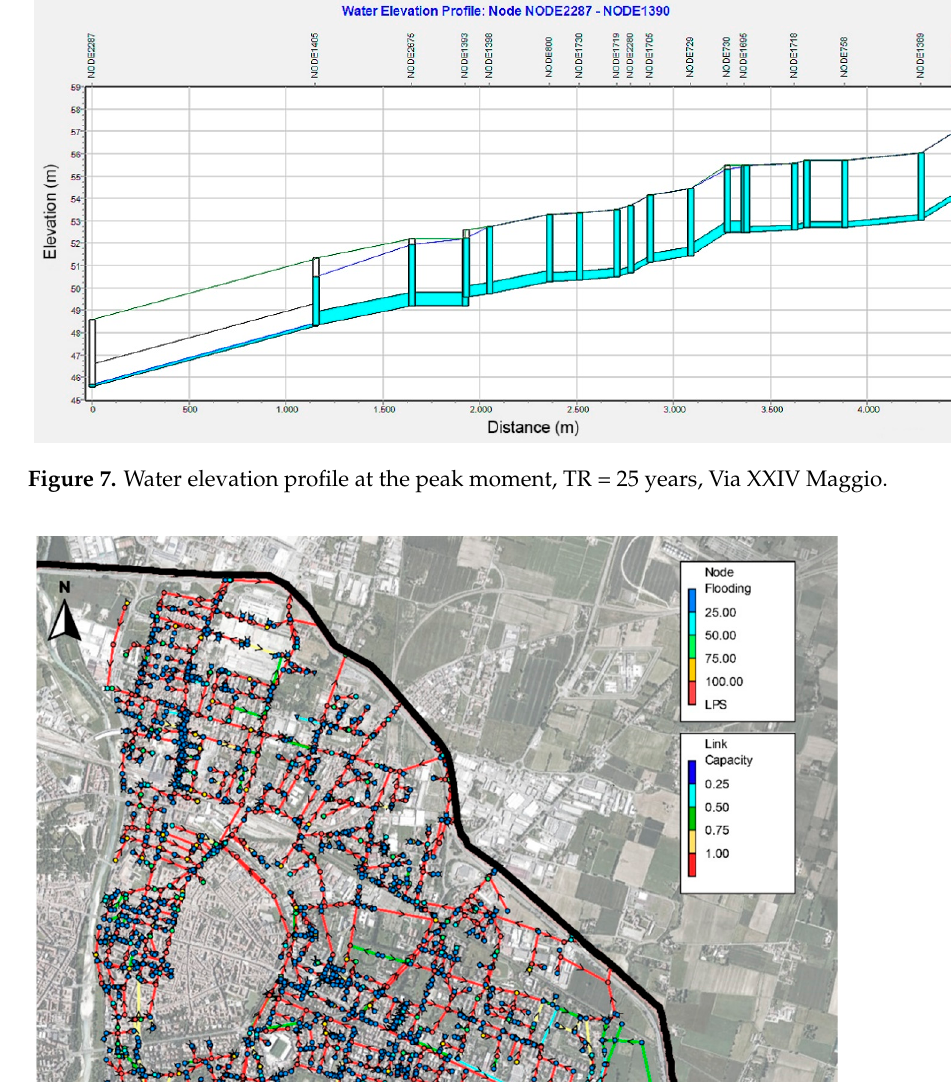
9 of 18 Figure 6. Flow hydrograph: TR = 25 years, Via XXIV Maggio. The first part of the graph shows an apparently unrealistic trend. The reason for this